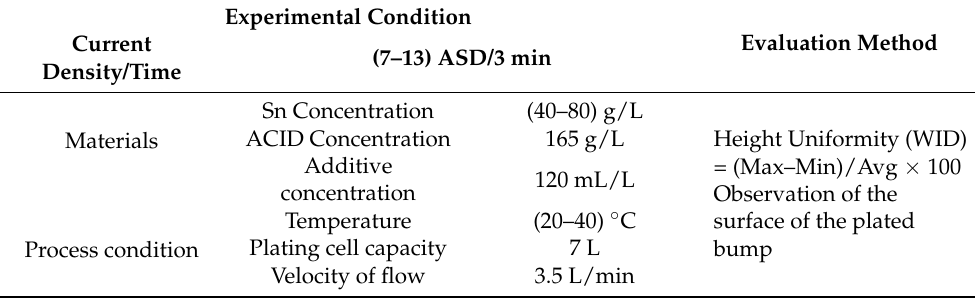
Table 1. Evaluation method for each process of the pure Sn bump. Experimental Condition